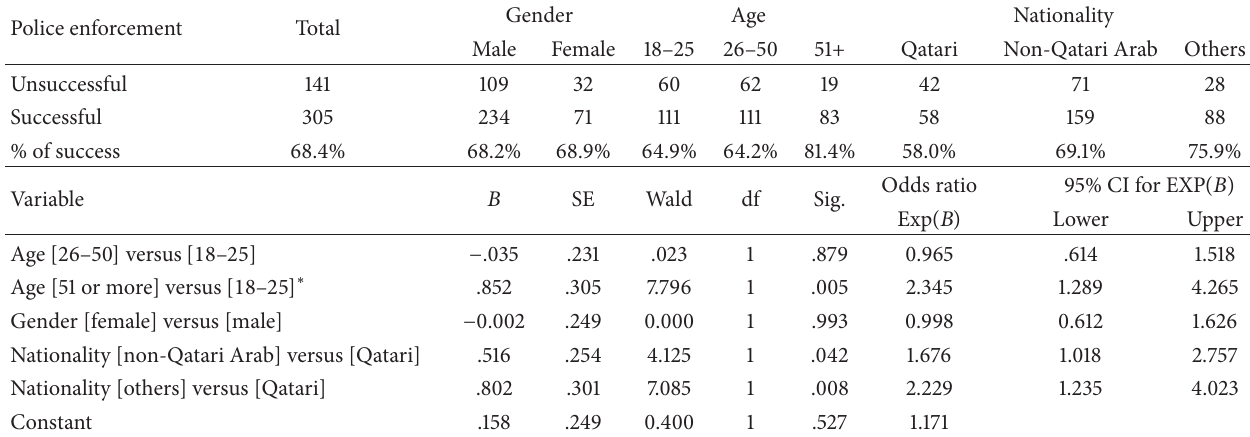
Table 4: Reported success and logistic model results for the police enforcement strategy.